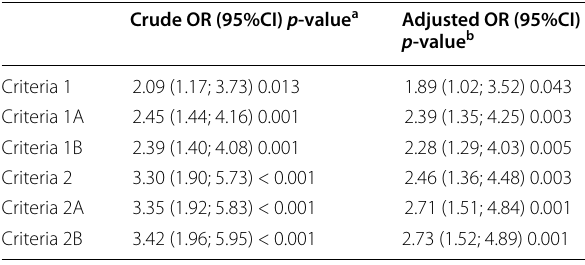
dialytic hypotension and hospital mortality